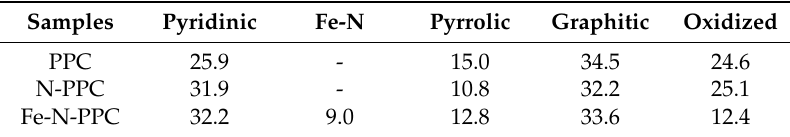
Table 2. Atomic ratio of N species from deconvolution N 1s